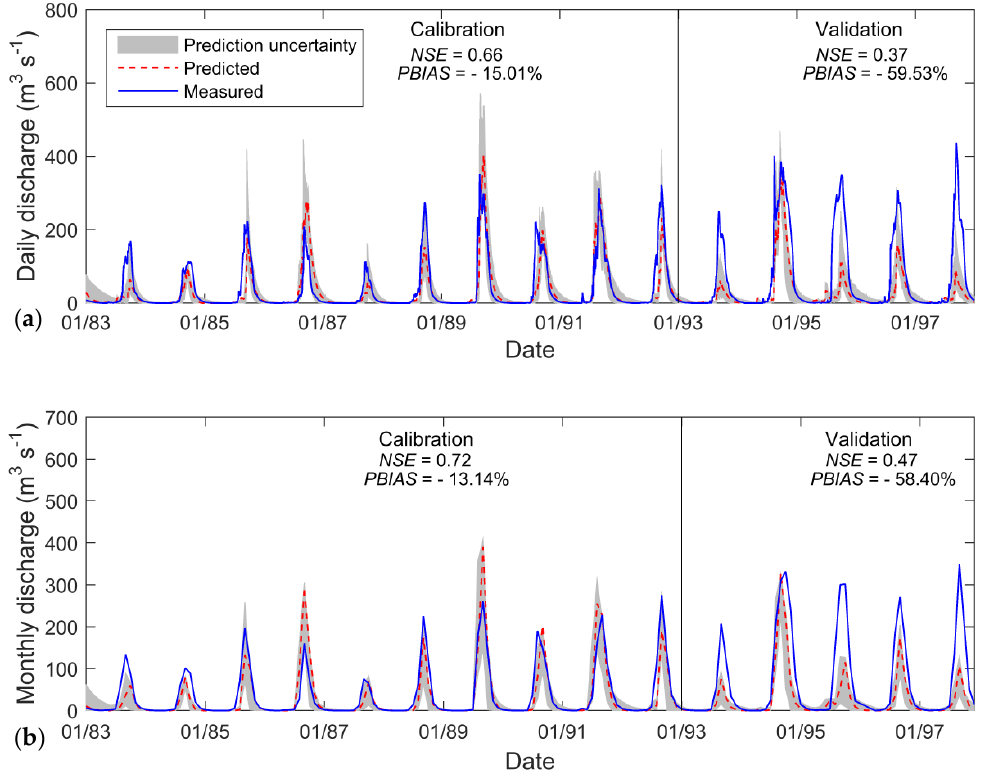
Figure 6. Predicted and measured discharges at Bougouni station at ( a ) daily and ( b ) monthly intervals during the calibration and validation periods with their corresponding statistics.